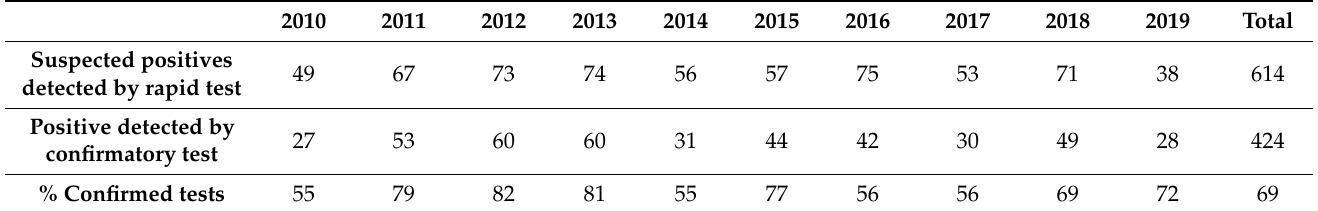
Table 4. Rapid test and confirmatory test positive samples. As shown in the table, out of 614